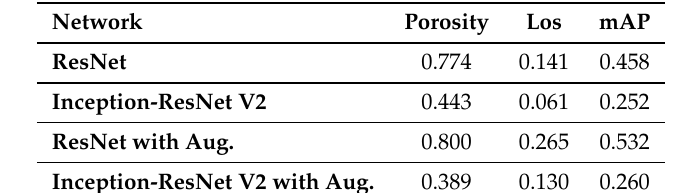
Table 3. Comparison of ResNet and Inception applied to Faster R-CNN. Performance improves with data augmentation for each model.